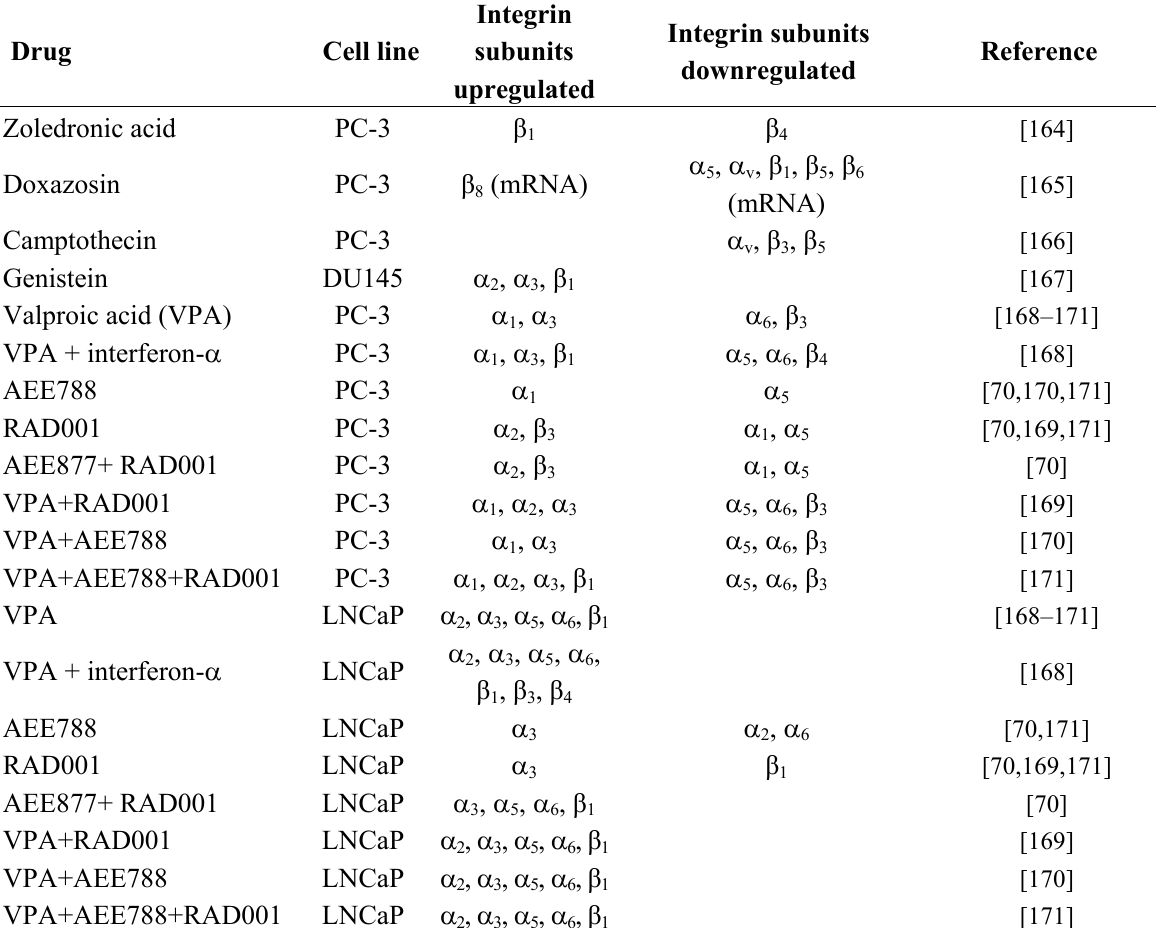
Table 5. Alterations in cell surface expression of integrin subunits in response to treatment with non-integrin targeting